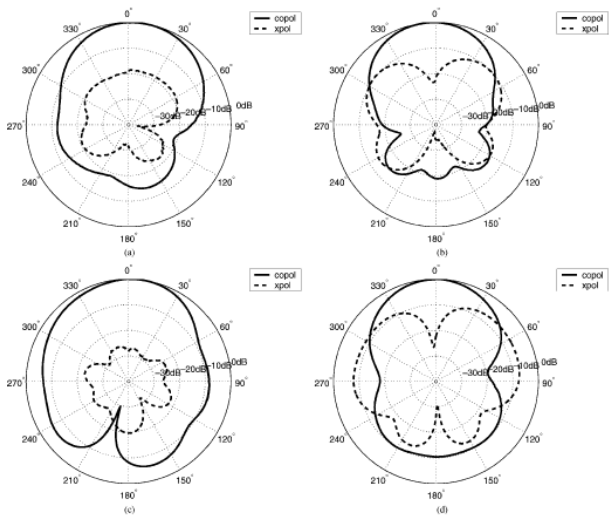
FIGURE 7. Radiation patterns of the wideband E-shaped patch design in Fig. 6b. (a) E-plane, 1.85 GHz. (b) H-plane, 1.85 GHz. (c) E-plane, 2.2 GHz. (d) H-plane, 2.2 GHz. Adapted from [13].